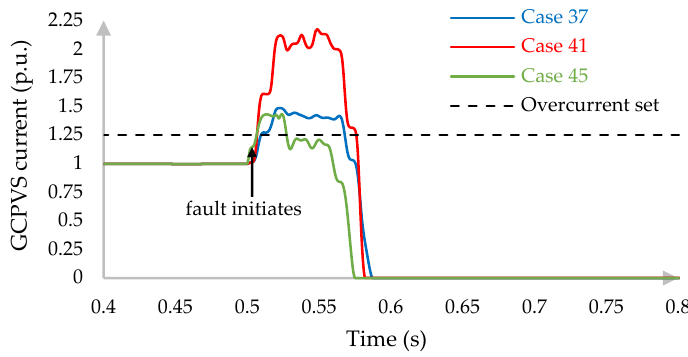
Figure 11. GCPVS output current of the faulted phase. Table 4. Simulation results of short-circuit fault case